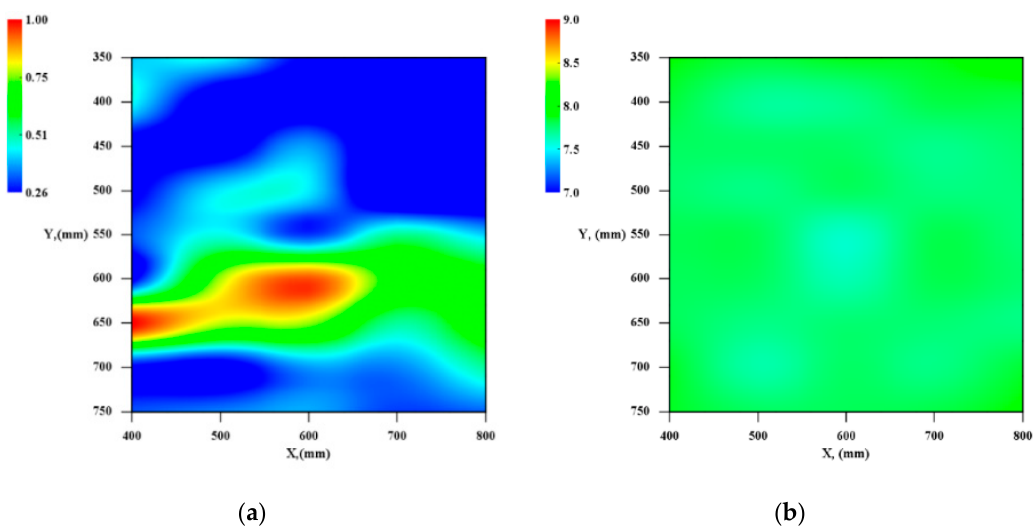
Figure 23. Contours of the evaluation results for Case_3: ( a ) DVA; ( b ) Dominant frequency.